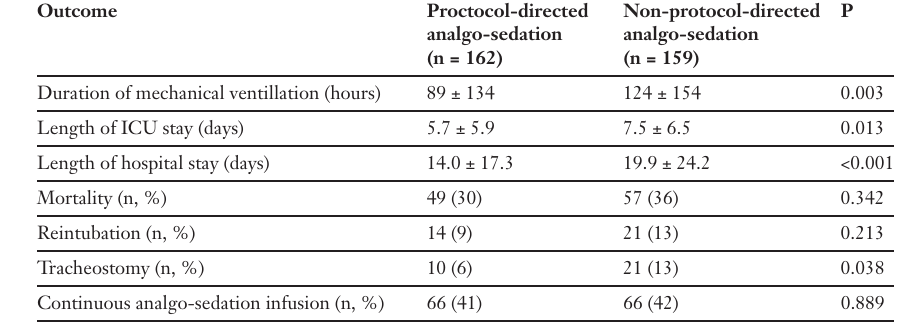
Effect of a systematic, standardized anal- gesia and sedation protocol on outcome [114].